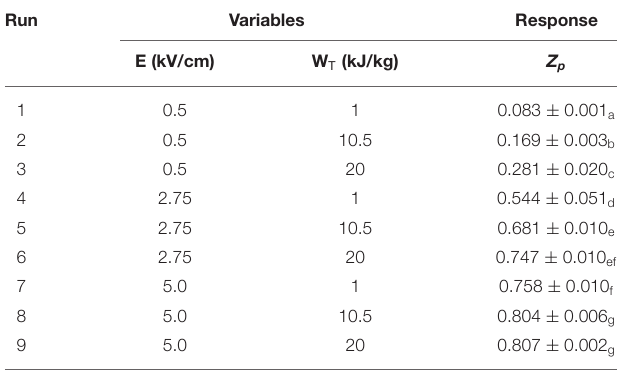
TABLE 1 | Actual values of the two independent variables investigated and response of the dependent variable (Zp) of the PEF treated grape pomace tissues. Run